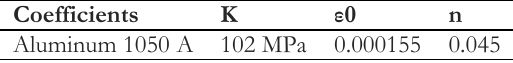
Table 2. Anisotropy coefficients as per Swift